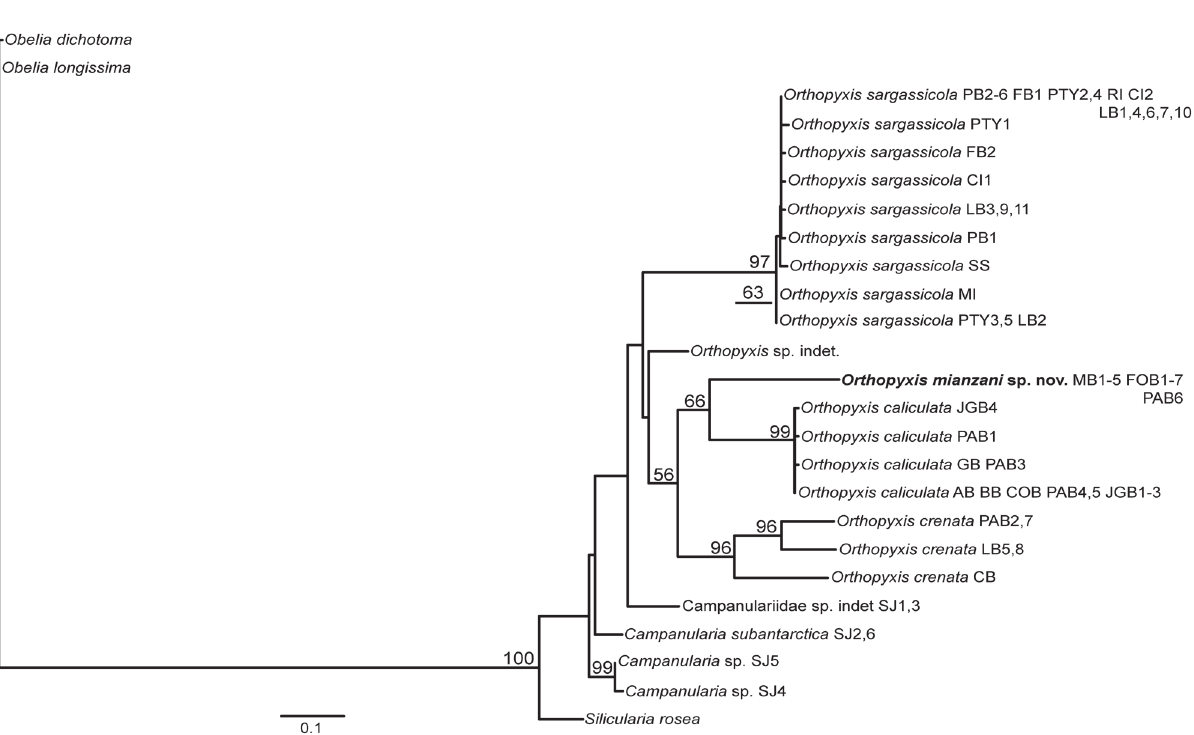
Fig 4. Maximum Likelihood tree based on 16S data. Bootstrap values are shown for each node. Nodes without numbers indicate support below 50.